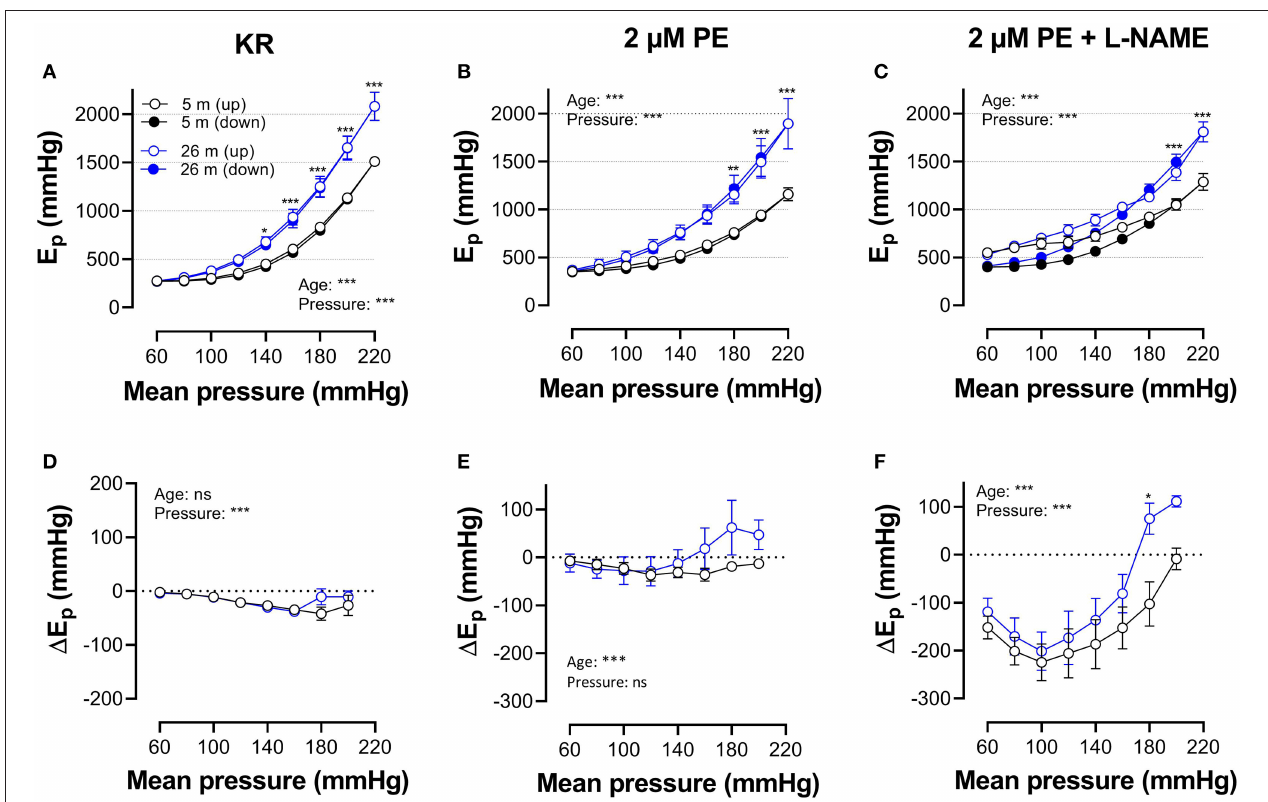
FIGURE 5 | Hysteresis is pressure, contraction and age dependent. Aortic segments of mice aged 5 months (black, n = 8) and 26 months (blue, n = 5) were subjected to upward (open symbols, up) and downward (closed symbols, down) pressure steps between 40 and 80mm Hg to 200–240mm Hg and back in control conditions (KR, A,D ) in the presence of 2 µ M PE (B,E) and 2 µ M PE in the presence of 300- µ M L-NAME to block endothelial NO release (C,F) . Absolute values of E p are shown in (A–C) , whereas, in (D–F) , data points for the upward pressure steps (open symbols, up) were compared at any given pressure, with data points for the downward pressure steps (closed symbols, down) (stiffness hysteresis). Two-way RM ANOVA with Sidak’s multiple comparison test, * p < 0.05, ** p < 0.01, *** p <